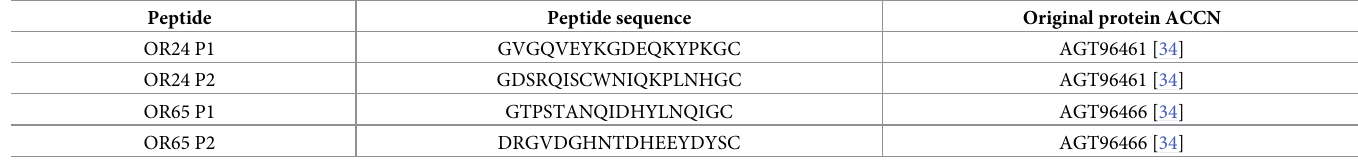
Table 1. Peptide